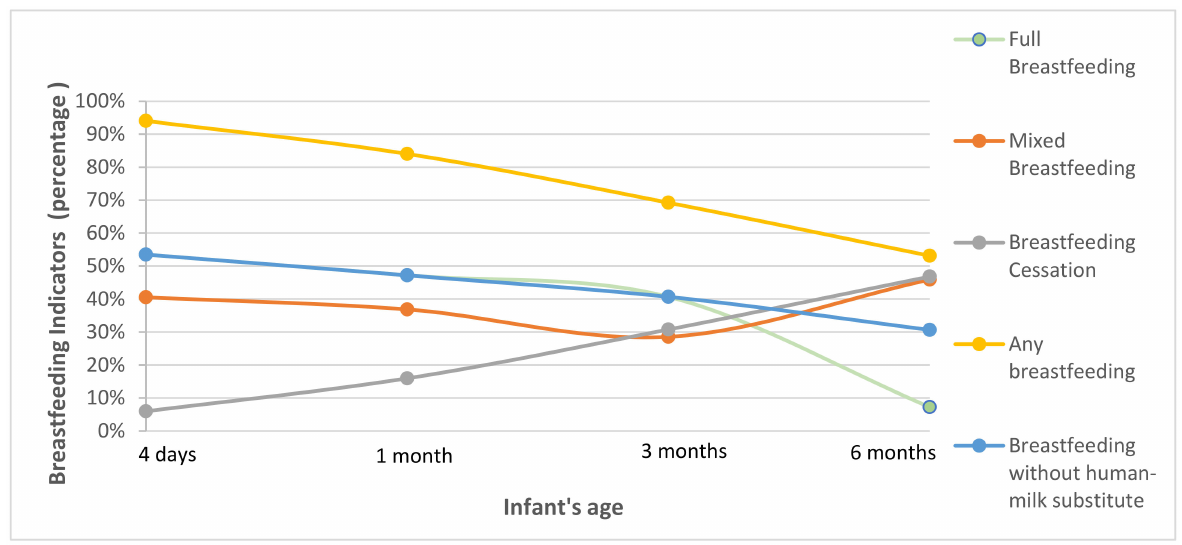
Figure 2. Breastfeeding indicators per time